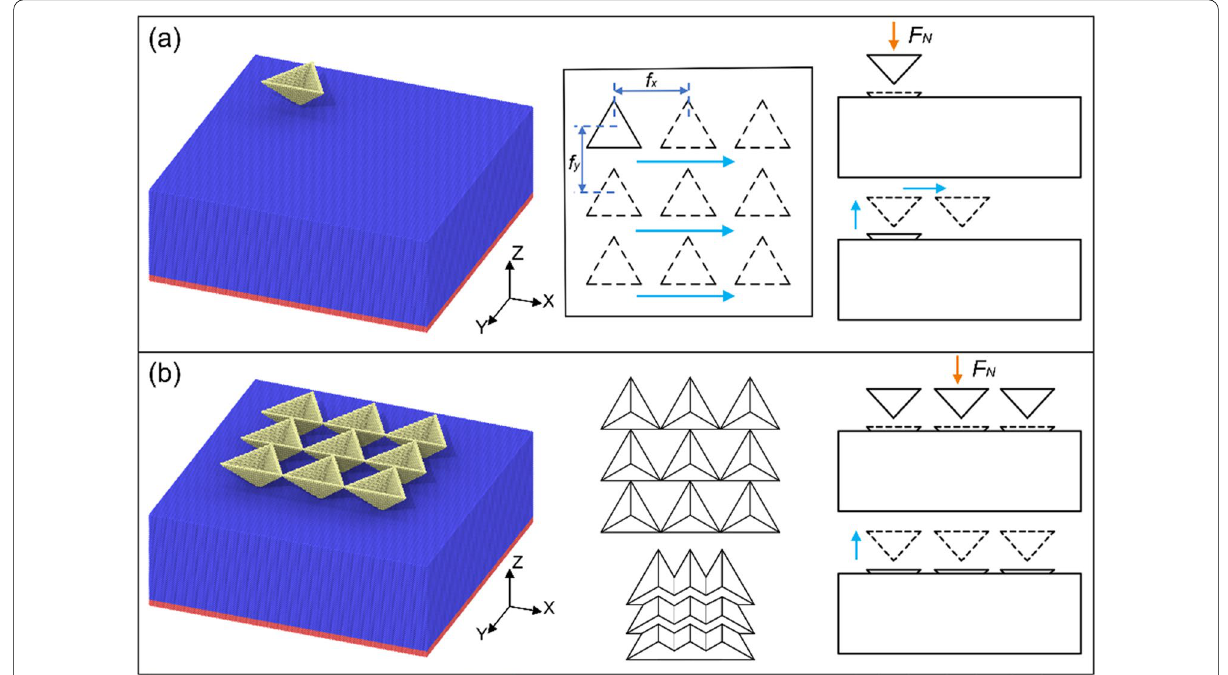
Fig. 1 MD simulation models a single indenter, b indenter